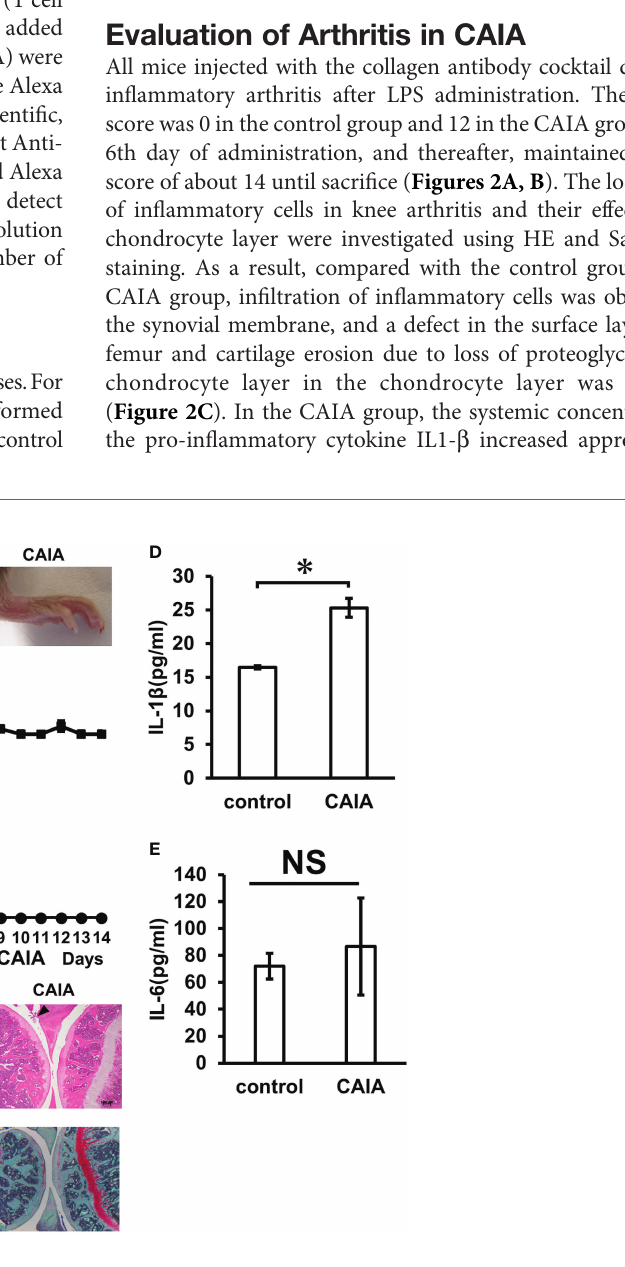
FIGURE 2 | In fl ammation evaluation. (A) Clinical photographs of hind legs of the control group and CAIA group mice. Swelling of the ankle was observed in the CAIA group. (Score 3) (B) Clinical severity of arthritis in control group and CAIA group after collagen antibody cocktail injection. Severity of arthritis in each foot was scored from 0 (no swelling) to 4 (erythema and severe swelling of the entire tarsal joint), and the total of 4 feet (0 – 16). In the CAIA group, the score was about 12 on day 6 of antibody administration. *P < 0.05. (C) Histological analysis of the hind paw of each group on day 14. The knee joint was stained with hematoxylin and eosin (a) and Safranin O (b) (1: tibia, 2: femur). Arrows indicate increased in fl ammatory cells. (scale bar: 100 m m) (D) Blood IL-1 b levels (pg/ml) in the control and CAIA groups. In the CAIA group, the IL- b concentration was 24.5 (pg/ml) *P < 0.05. (E) Blood IL-6 levels (pg/ml) in the control and CAIA groups. There was no signi fi cant (NS) difference between the control group and the CAIA group. NS, not signi fi